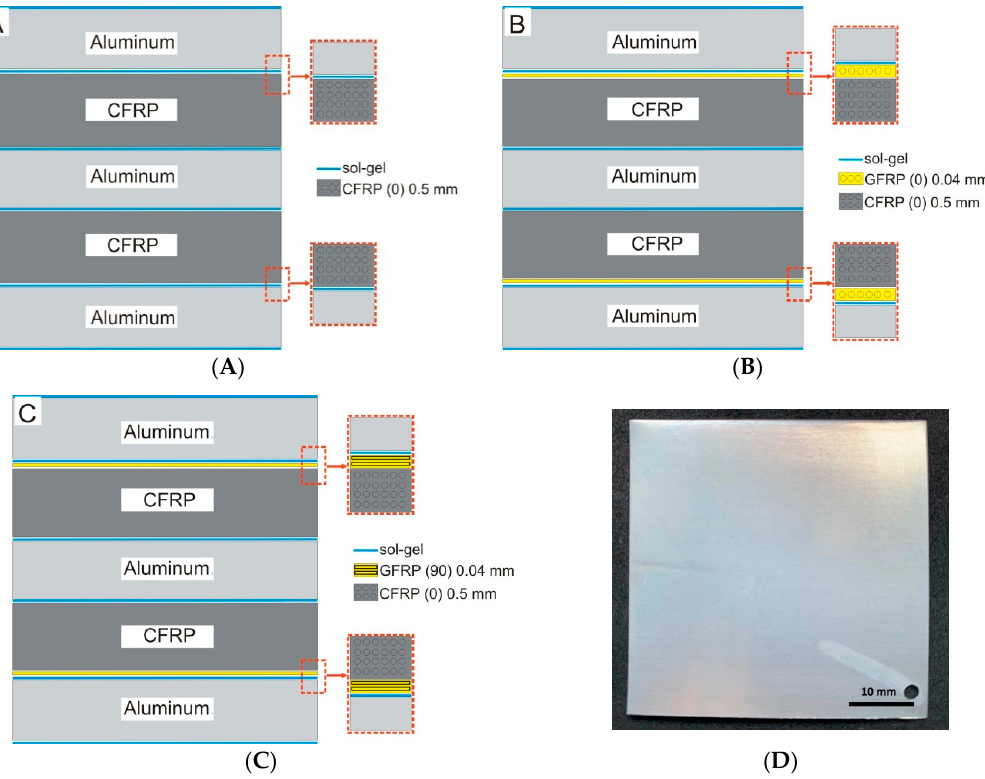
Figure 1. Sample configuration schemes: ( A ) aluminum and carbon fiber reinforced polymer (Al-